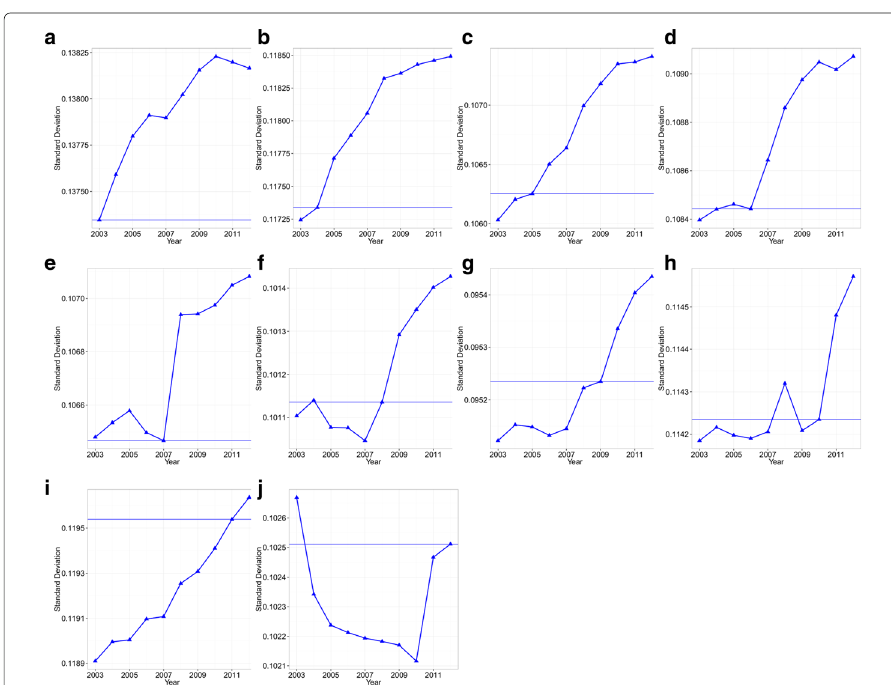
Fig. 5 Standard deviation of each y pos s for years 2003 to 2012. The horizontalblueline denotes the standard t (cid:2) | t deviation in year t . a 2003; b 2004; c 2005; d 2006; e 2007; f 2008; g 2009; h 2010; i 2011; j